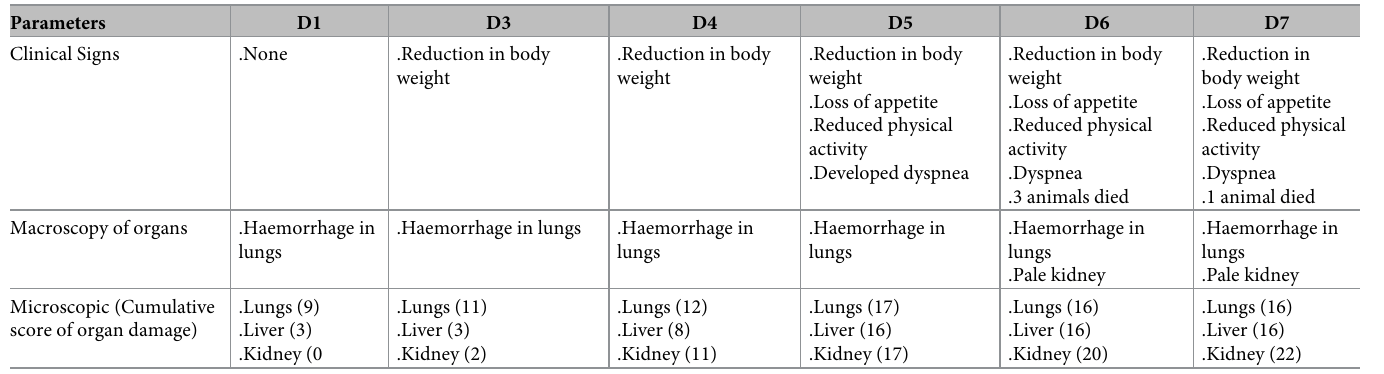
Table 3. Summary of disease progression in hamsters infected with L . interrogans strain HP358. Parameters D1 D3 Clinical Signs